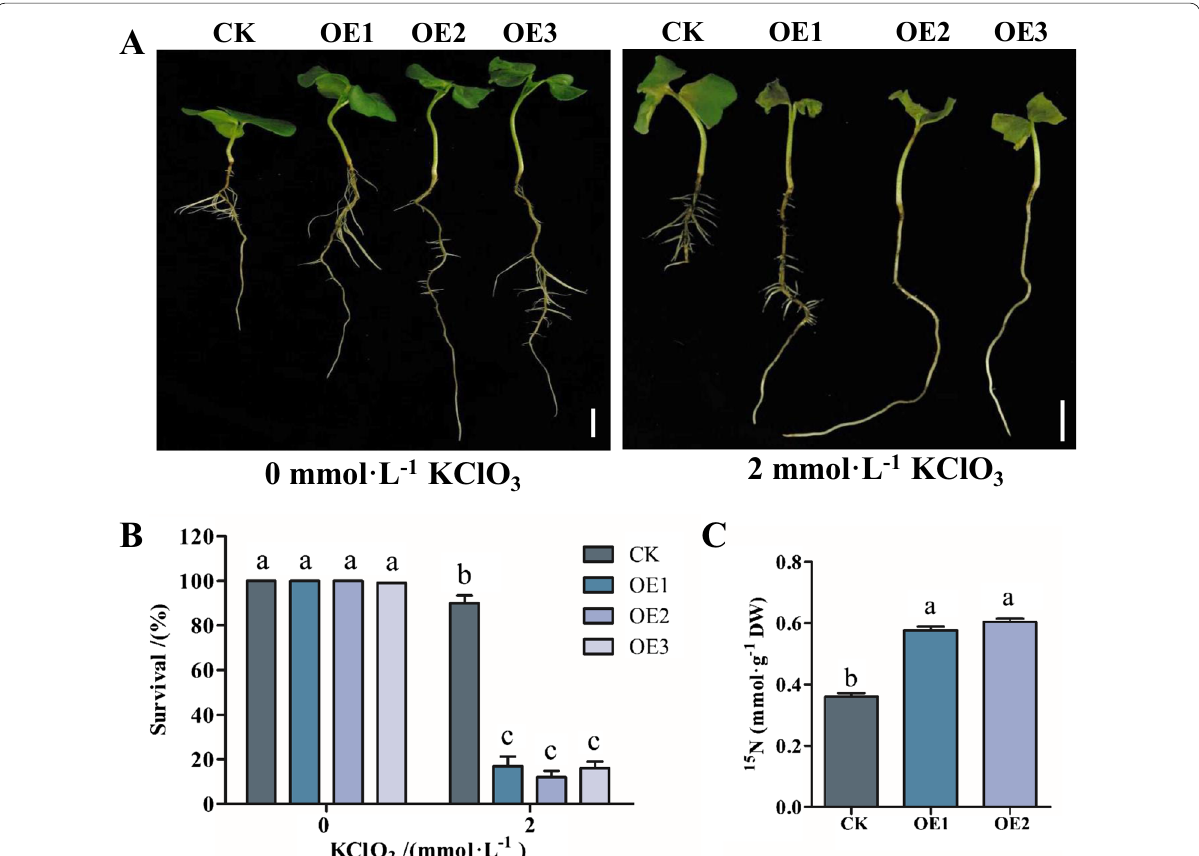
Fig. 4 AtNLP7 enhancef N uptake in cotton. A Chlorate sensitivity. A representative plant is shown after chlorate treatment. Bar % after chlorate treatment as in ( A ). Results are average values ( P < 0.05) from Duncan’s multiple range tests. C Accumulation of 15 N isotope in 2-weeks-old seedlings. Results are average values replicates, 16 plants per replicate). Letters denote significant differences ( P < 0.05) from Duncan’s multiple range